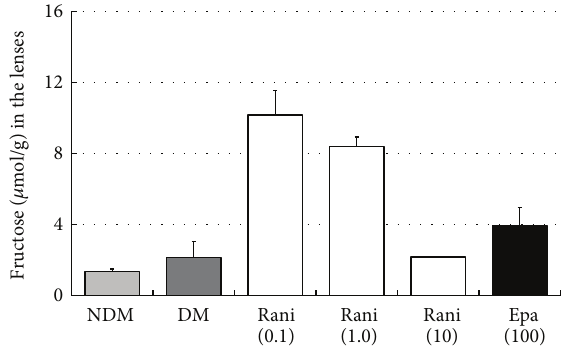
Figure 9: The fructose levels in the lenses at 15 weeks. Although there seems to be a dose-dependent decrease in the fructose levels in the lenses with administration of ranirestat, the fructose level in the untreated lenses is very low. NDM: non-diabetes mellitus; DM: diabetes mellitus; rani: ranirestat; epa: epalrestat.